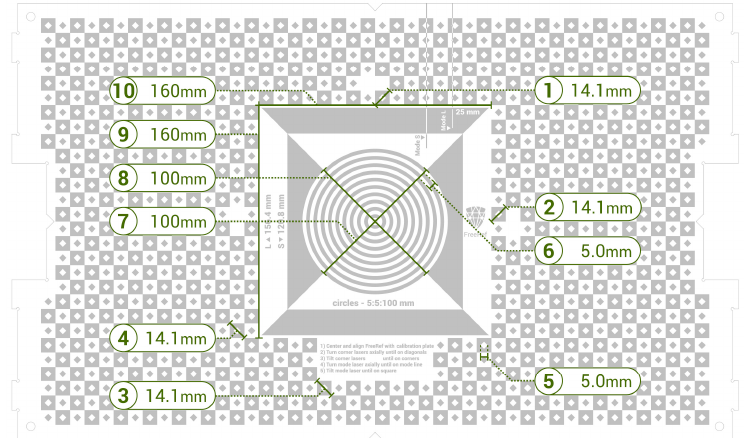
Figure 8. Scheme of the calibration plate (in color negative, because the black parts in the image are laser-engraved on the plate, which turns white where it is engraved) and the ten veri fi cation lines used for the veri fi cation tests.